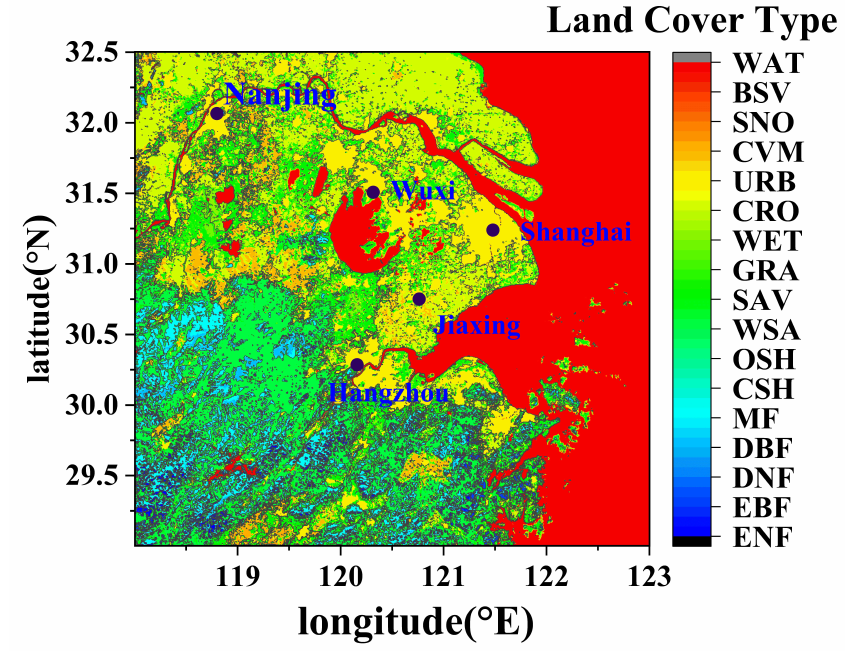
Figure 8. MCD12Q1-LC1 distribution of the selected